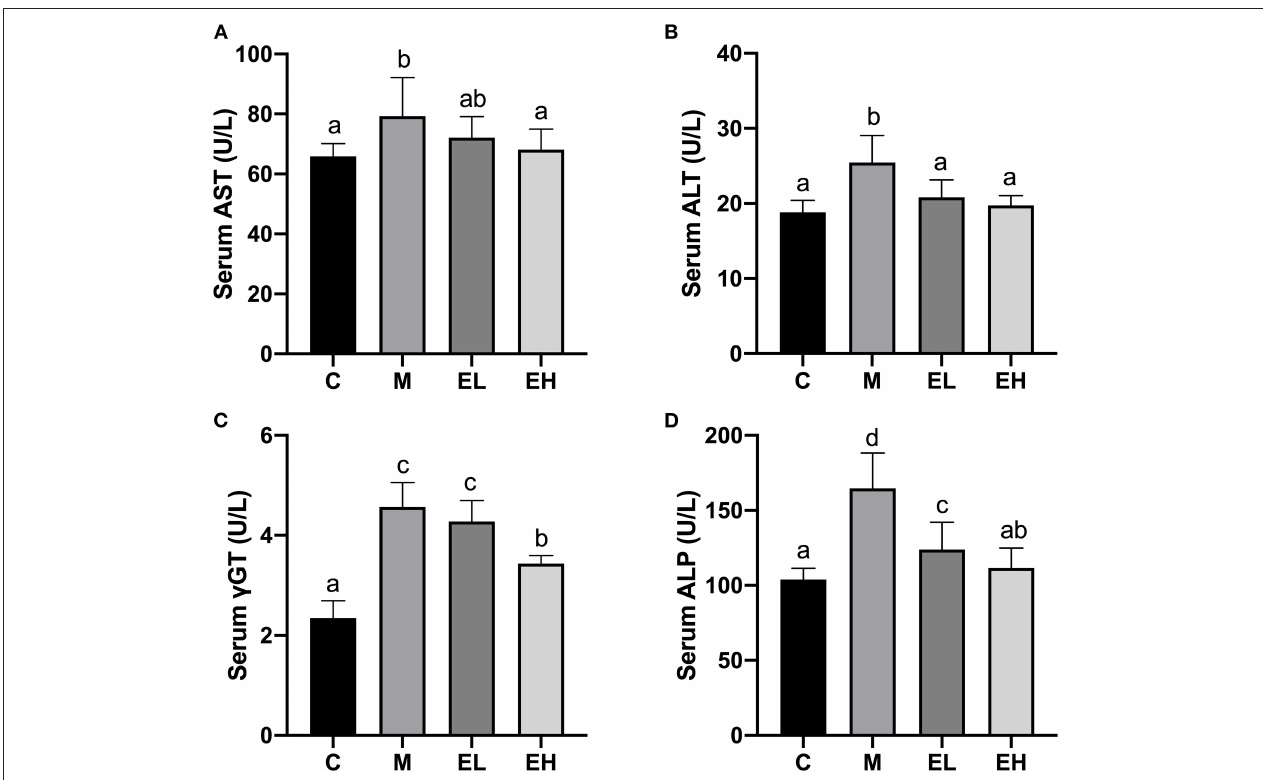
FIGURE 1 | Effect of ellagic acid on serum biochemical makers in mice. (A) AST; (B) ALT; (C) γ GT; (D) ALP. Values represent the mean ± SD ( n ≥ 6). Labeled means without a common letter difference. p < 0.05 by one-way ANOVA followed by Duncan’s test. C, normal group; M, model group; EL, low dose of ellagic acid group; EH, high dose of ellagic acid